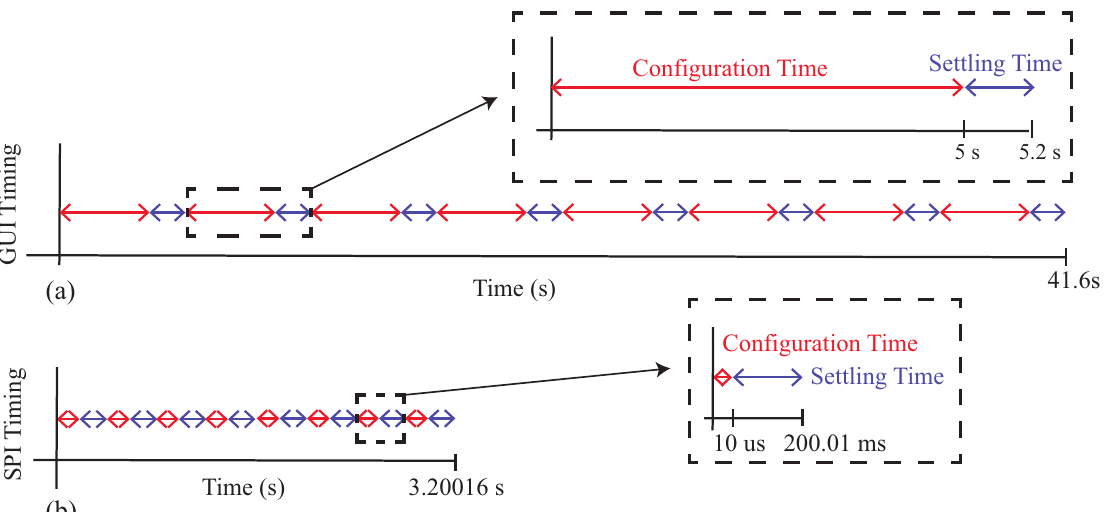
Figure 14. Timing diagram for MAX3000x multi-frequency impedance measurements using ( a ) a manual GUI configuration and ( b ) a microcontroller